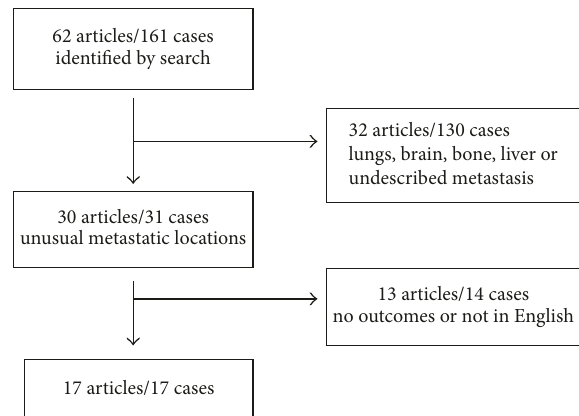
Figure 4: Selection for review of literature: references were obtained from the PubMed database, using the keywords “phyllodes tumor